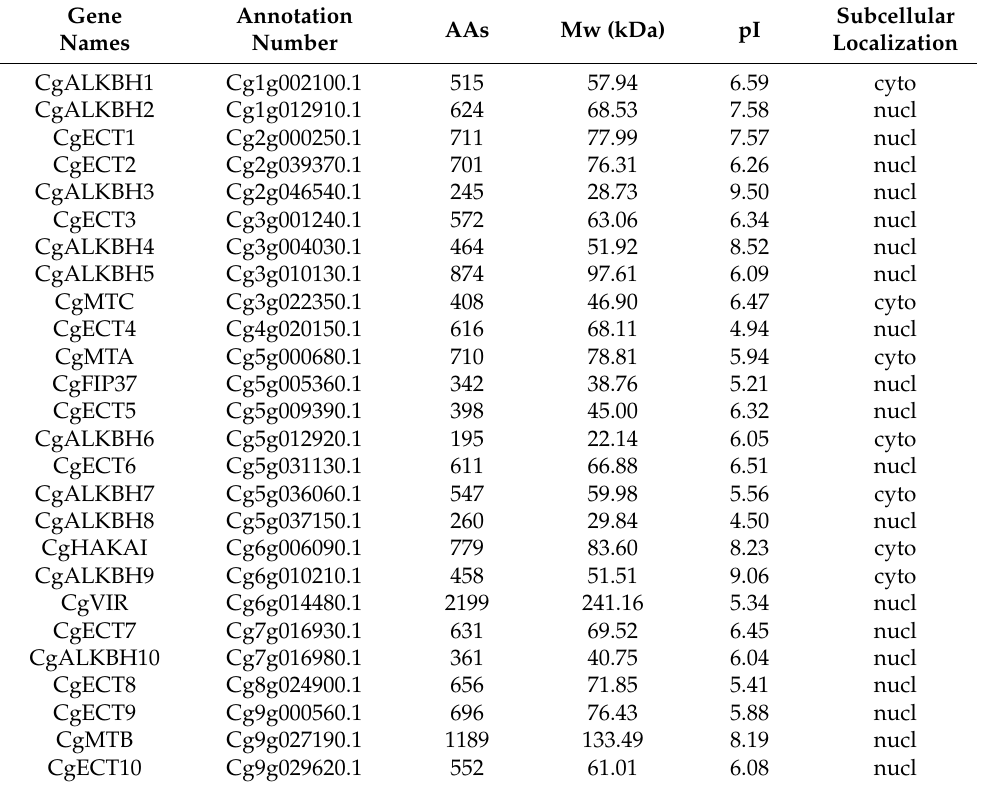
Table 2. The m 6 A regulatory genes identified in C. grandis